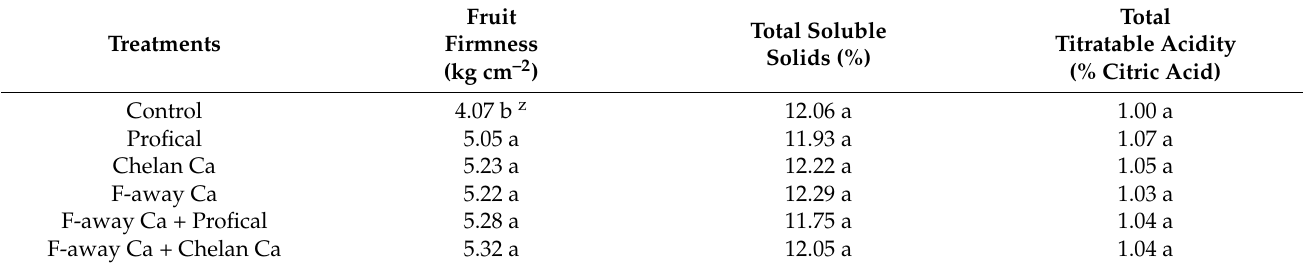
Table 4. Fruit firmness, total soluble solids and total titratable acidity after two months of cold storage (means of 2 years).